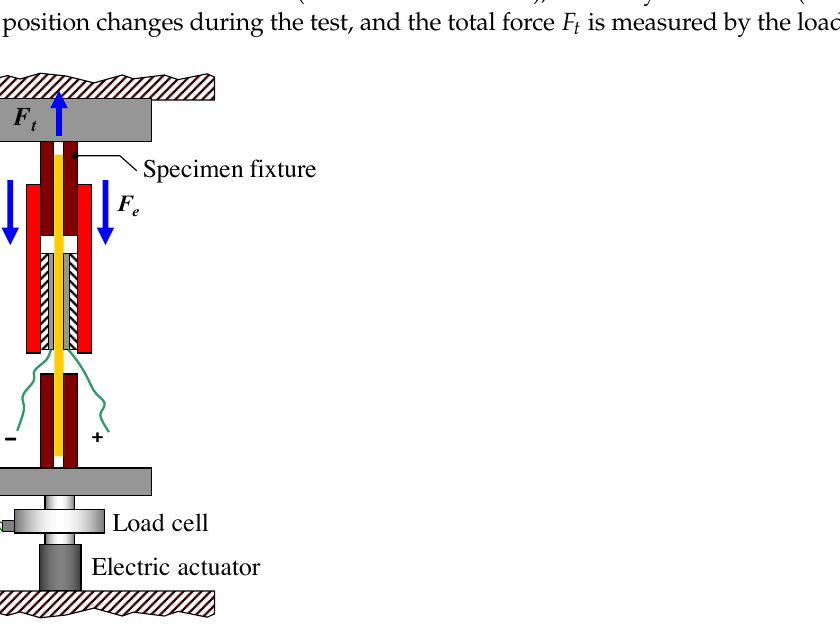
Figure 7. Uniaxial tensile load test: the specimen (orange), inserted into the electrodes holder (dashed black and red), is held by two fixtures (dark red). During the test, the upper fixture is moved upwards. When an external electric field is applied, the specimen contracts and the load cell measures the total force F t , given by the contributions of both the tensile reaction force F m of the material and the contraction force F e , as described by Equation